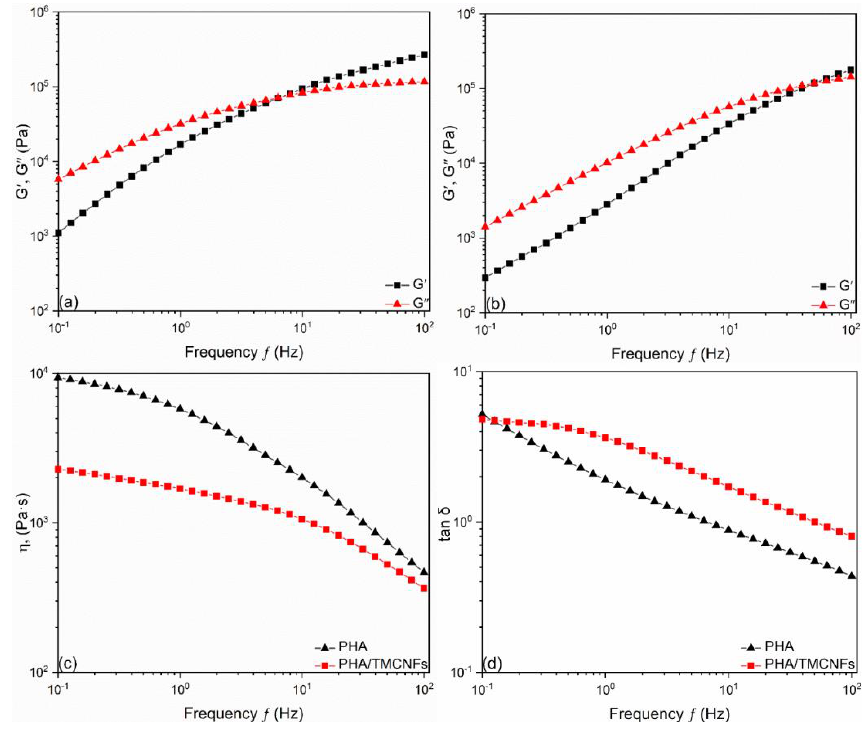
Table 3. Independent samples t -test of PHA and PHA–TMCNFs failure load.